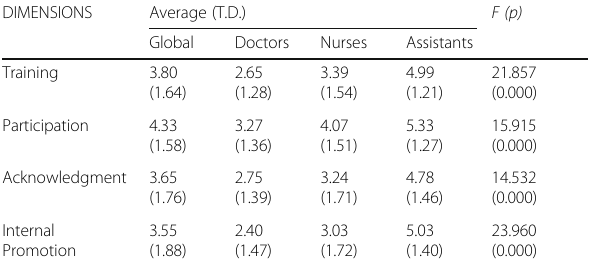
Table 1 (abstract 0349). Descriptive analysis of the factors of the high- commitment human resource scale according to the professional